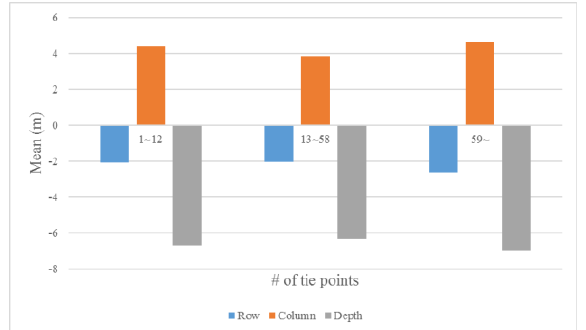
Figure 13. Mean difference in case of different number of tie points